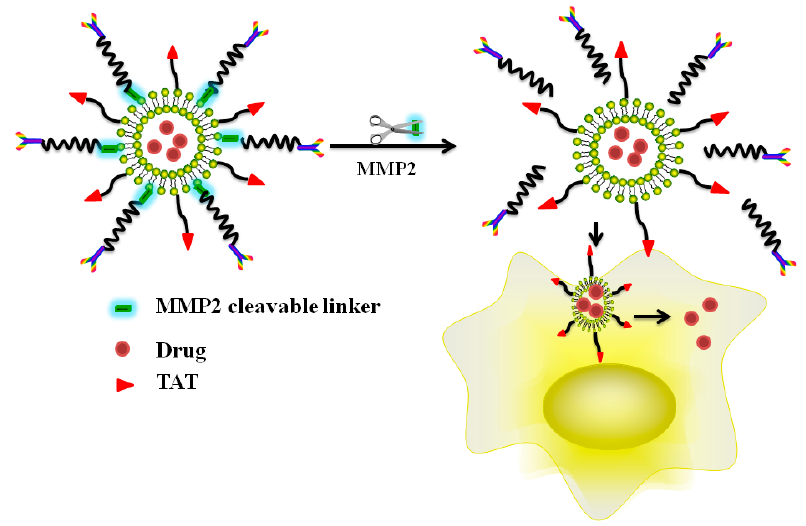
Figure 5. Illustration of the MMP2-triggered, CPP-mediated intracellular delivery strategy of drug-encapsulated liposome (Reproduced according to [114]). drug-encapsulated liposome (Reproduced according to